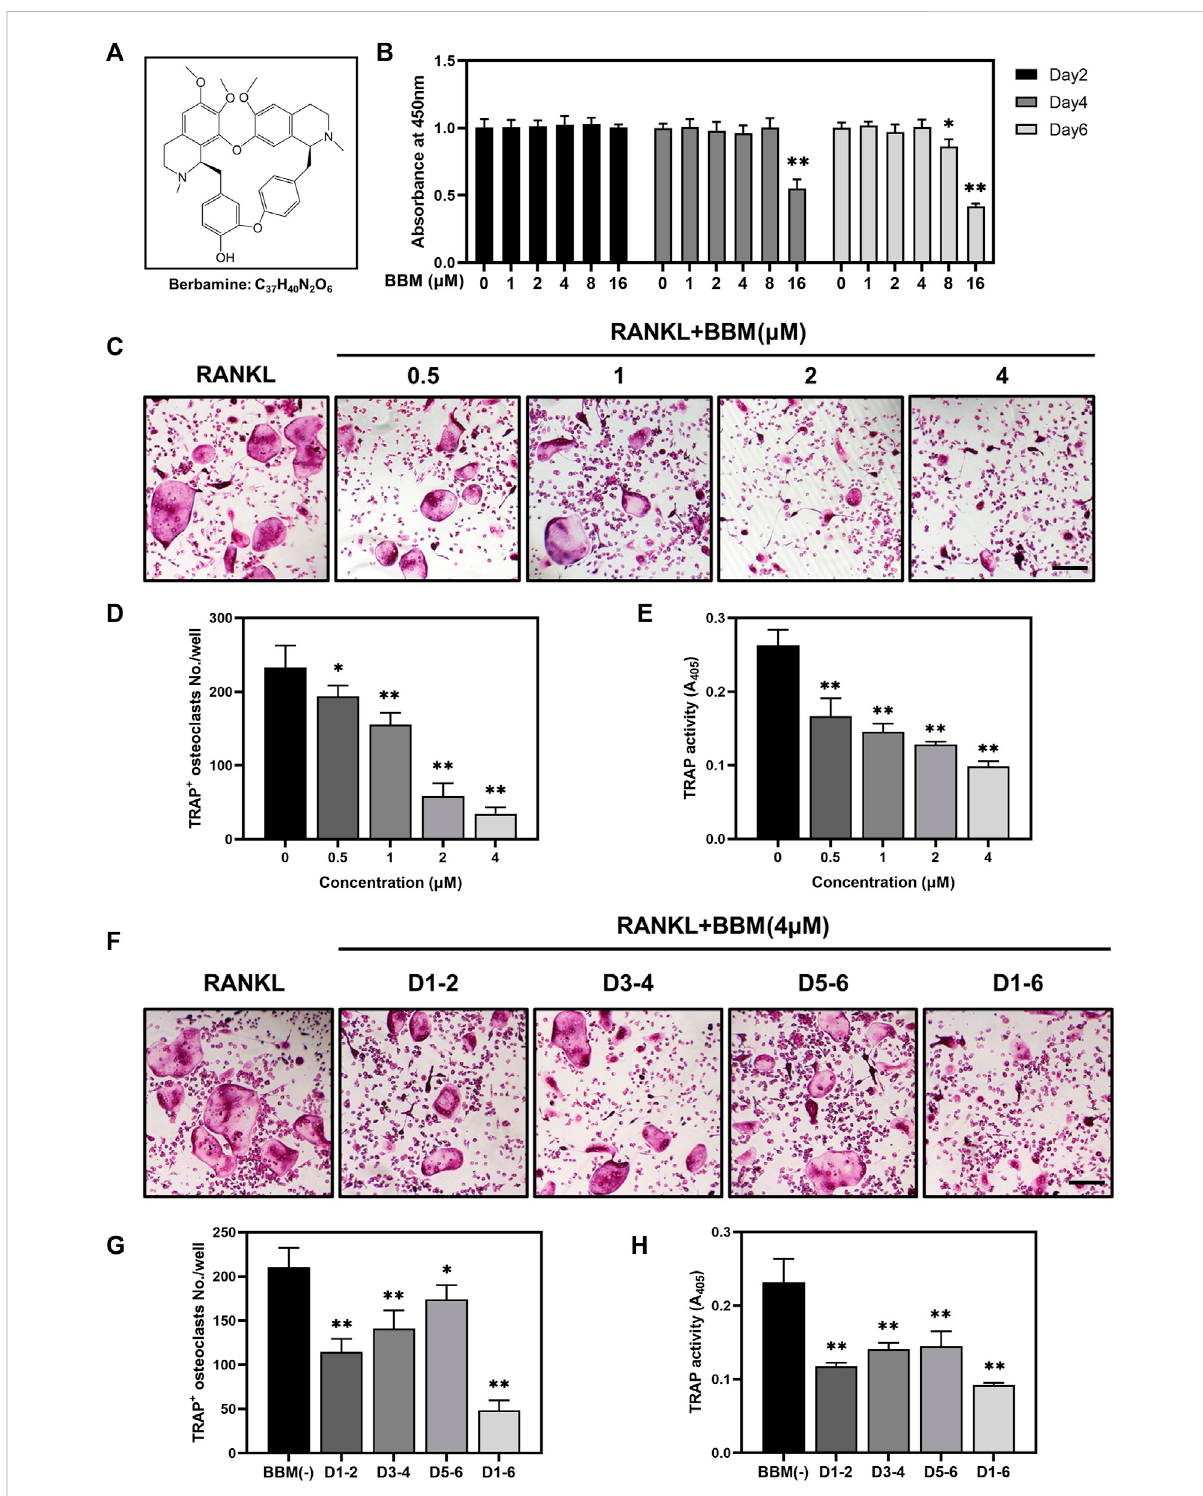
FIGURE 1 BBM suppresses RANKL-induced osteoclastogenesis in vitro . (A) Chemical structure of BBM. (B) BMMs were treated with BBM (0, 1, 2, 4, 8, and 16 μ M) for 2, 4, and 6 days. Cell viability was determined by CCK-8 assay. (C) Representative images of TRAP staining in BMMs cultured with RANKL (50 ng/ml) and the indicated concentrations of BBM for 5 – 7 days (scale bar = 200 μ m). (D,E) Quantitative analysis of the number of mature osteoclasts (D) andTRAPactivityintheculturesupernatant (E) . (F) RepresentativeimagesofTRAPstaininginBMMsculturedwithRANKL(50 ng/ ml) and 4 μ M BBM for the indicated period (scale bar = 200 μ m). (G,H) Quantitative analysis of the number of mature osteoclasts (G) and TRAP activity in the culture supernatant (H) . * p < 0.05 and ** p < 0.01 compared to the control